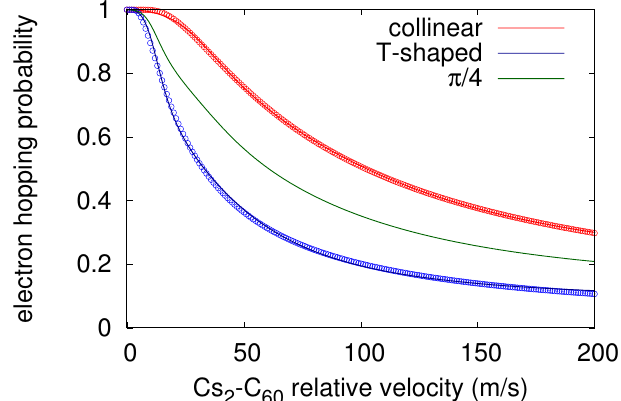
Figure 3. Computed (points) and fitted (lines) of probability for electron hopping obtained using the Landau–Zener model at collinear and T-shaped orientations as function of relative velocity [42]. Simple analytic extension at whatever be the orientation is also shown for an intermediate orientation θ = π